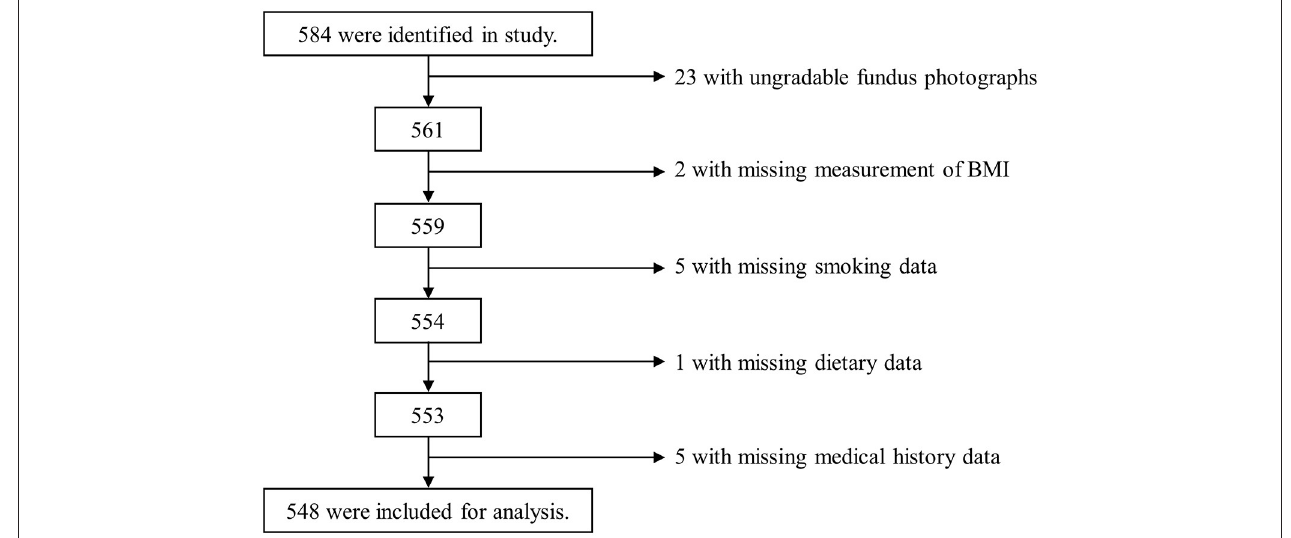
FIGURE 1 | Flow chart showing participant selection in the present study. BMI, body mass